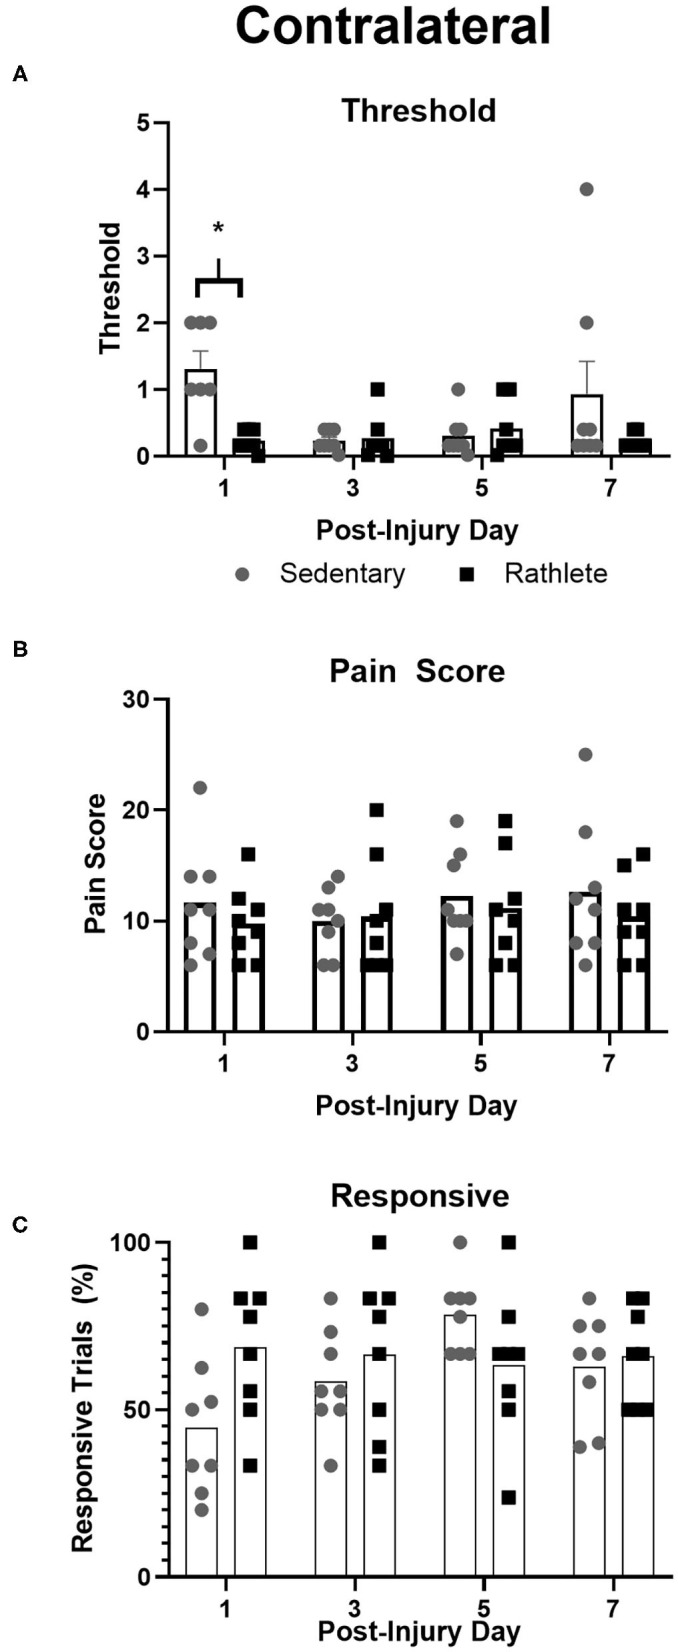
Von Frey Test of allodynia. Neuropathic pain, a marker for “headache,” was measured in rathlete and sedentary shams using von Frey filaments. Threshold (A) indicated the smallest size filament that caused a withdraw reaction 3 consecutive times. Pain score (B) was the sum of responses up to and including threshold. Responsive (C) was the percentage of withdraw responses. *p < 0.05.